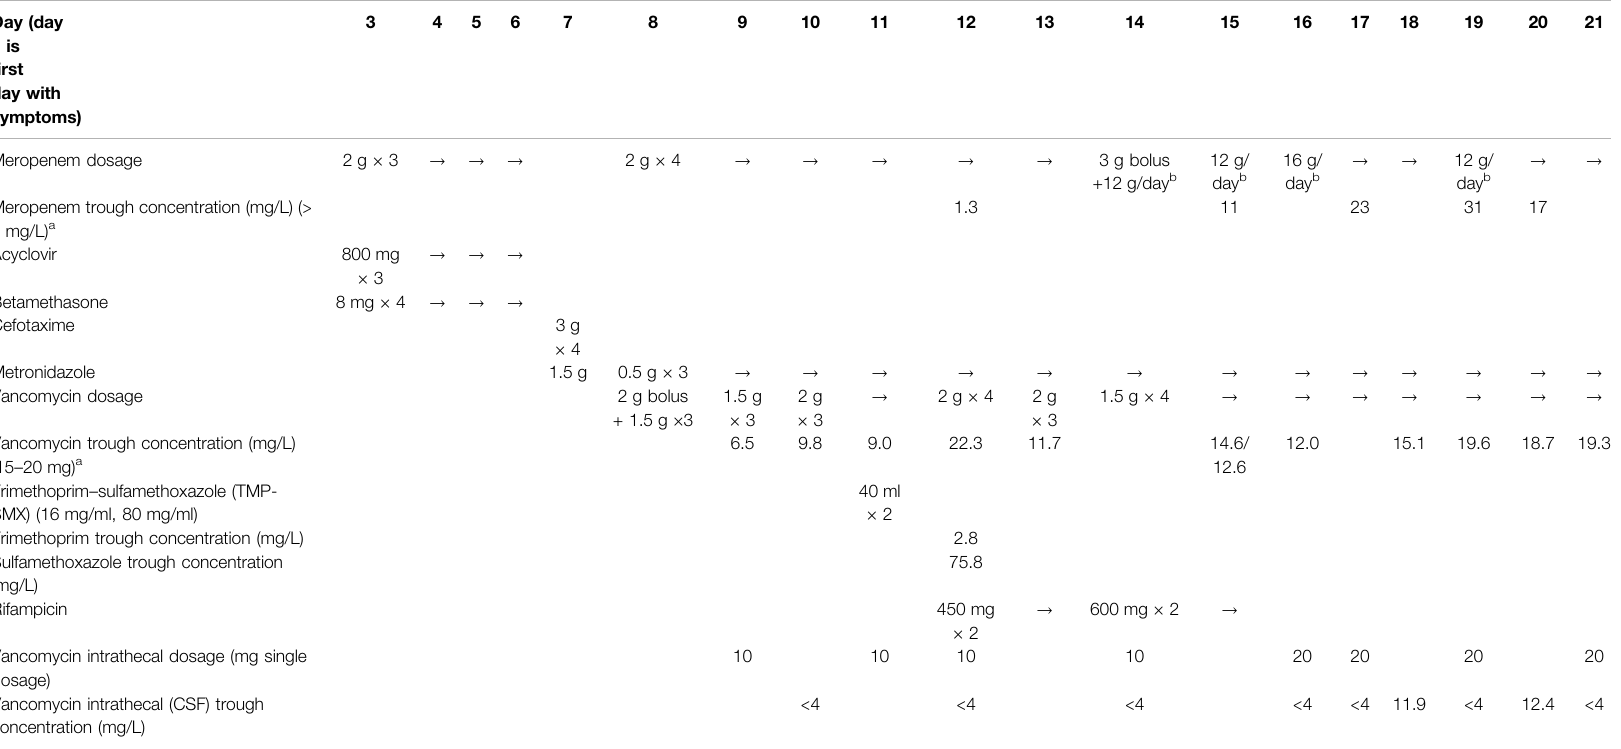
Vancomycin intrathecal (CSF) trough concentration (mg/L) a Reference values. b Continuous